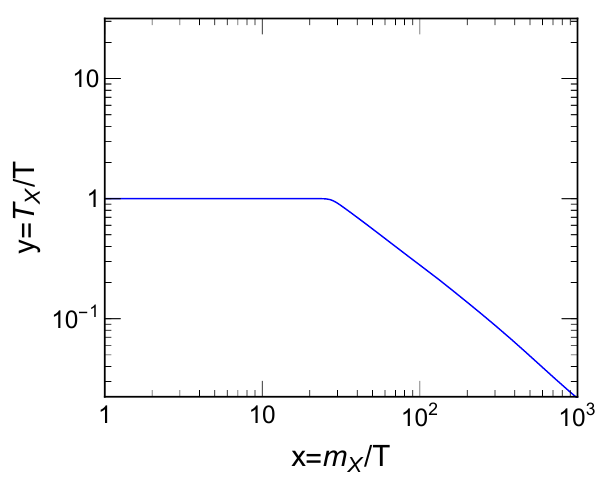
Figure 6 . T X /T as a function of x for the case that T S = T can be maintained until after the time of T X 6 = T , which is due to a large SM SM → S rate. Here we use m X = 20 GeV, r = 1 . 05 , g dm = 0 . 257 , and α = 1 . 53 × 10 − 6 as input